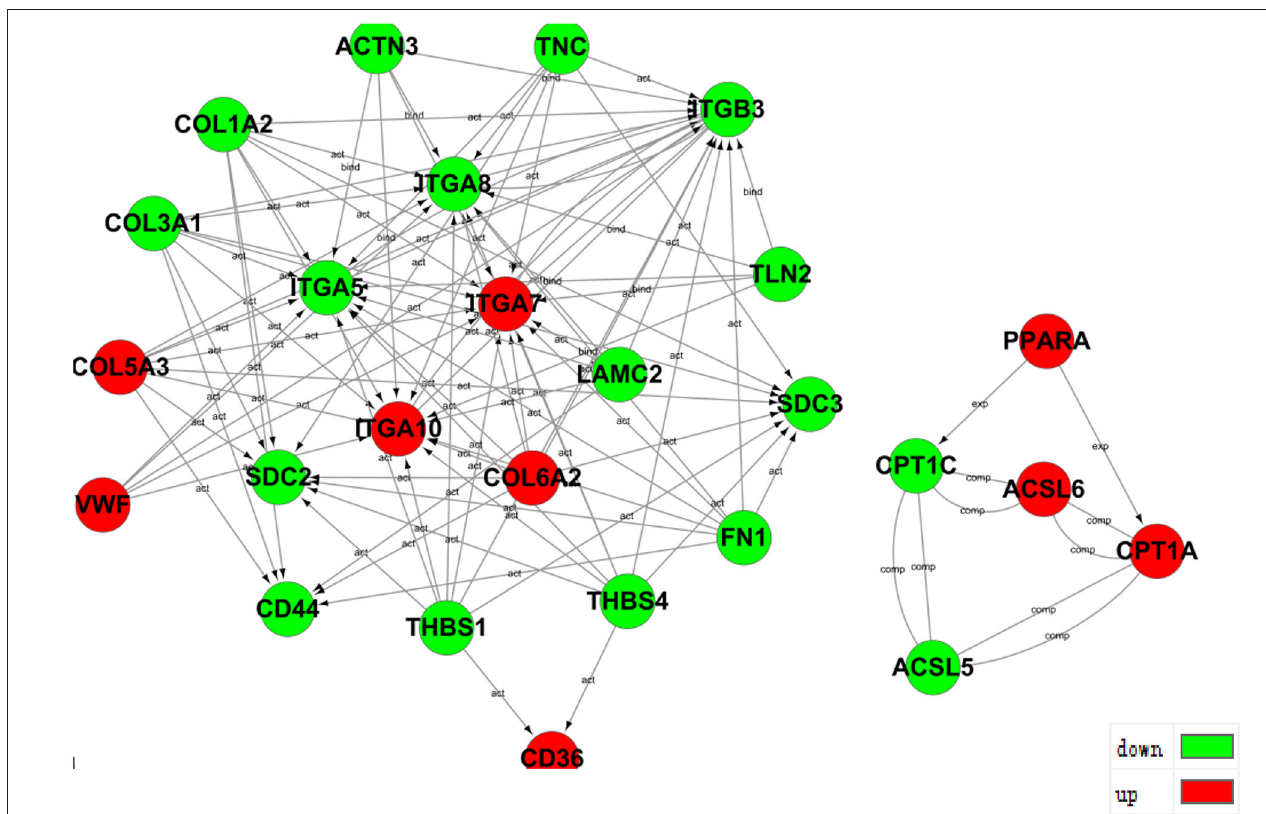
FIGURE 7 | Prediction of protein interaction among partial differentially expressed